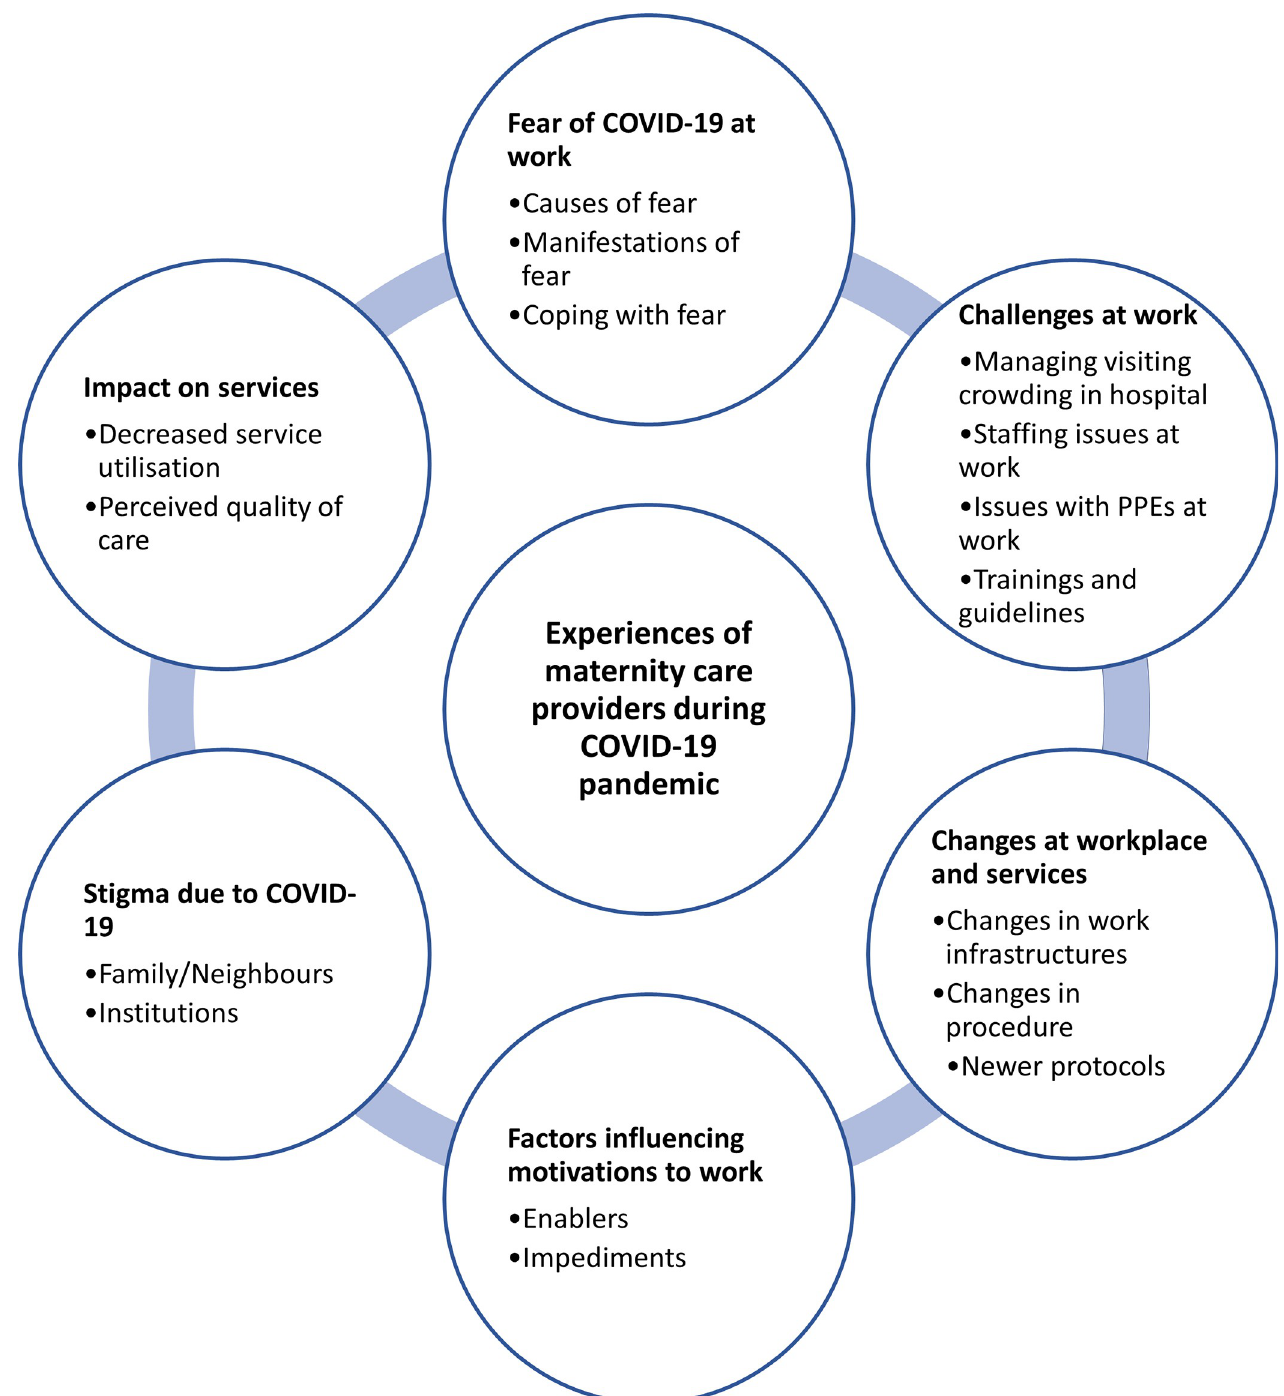
Fig 1. Themes and